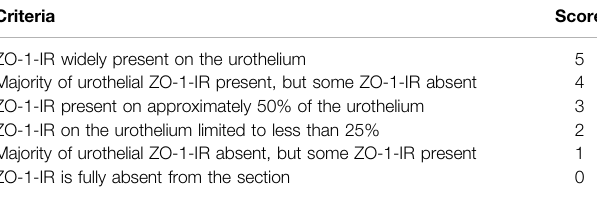
TABLE 2 | Microscopic scoring method for semi-quanti fi cation of ZO-1-IR (adapted from Diezmos et al., 2018).